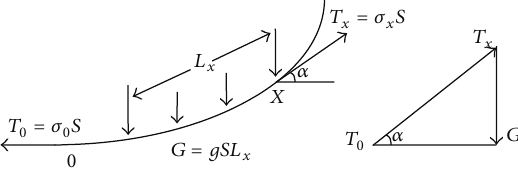
Figure 1: The static diagram of